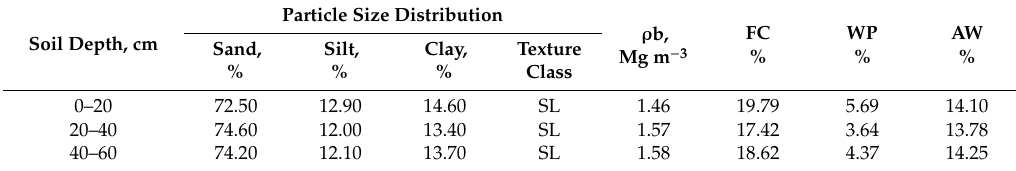
Table 1. Some physical properties of the experimental soil.